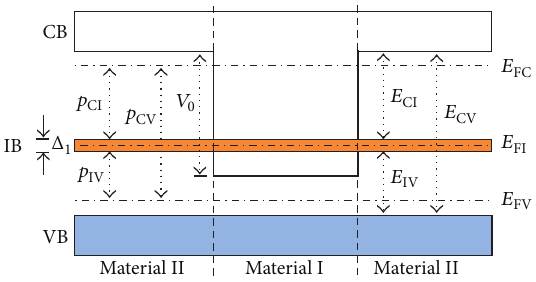
Figure 5: Construction of energy band diagram for two semicon- ductor materials (material I; InAs 0.9 N 0.1 : quantum dot, material II; GaAs 0.98 Sb 0.02 : barrier width) to create a heterostructure for one intermediate band solar cell.